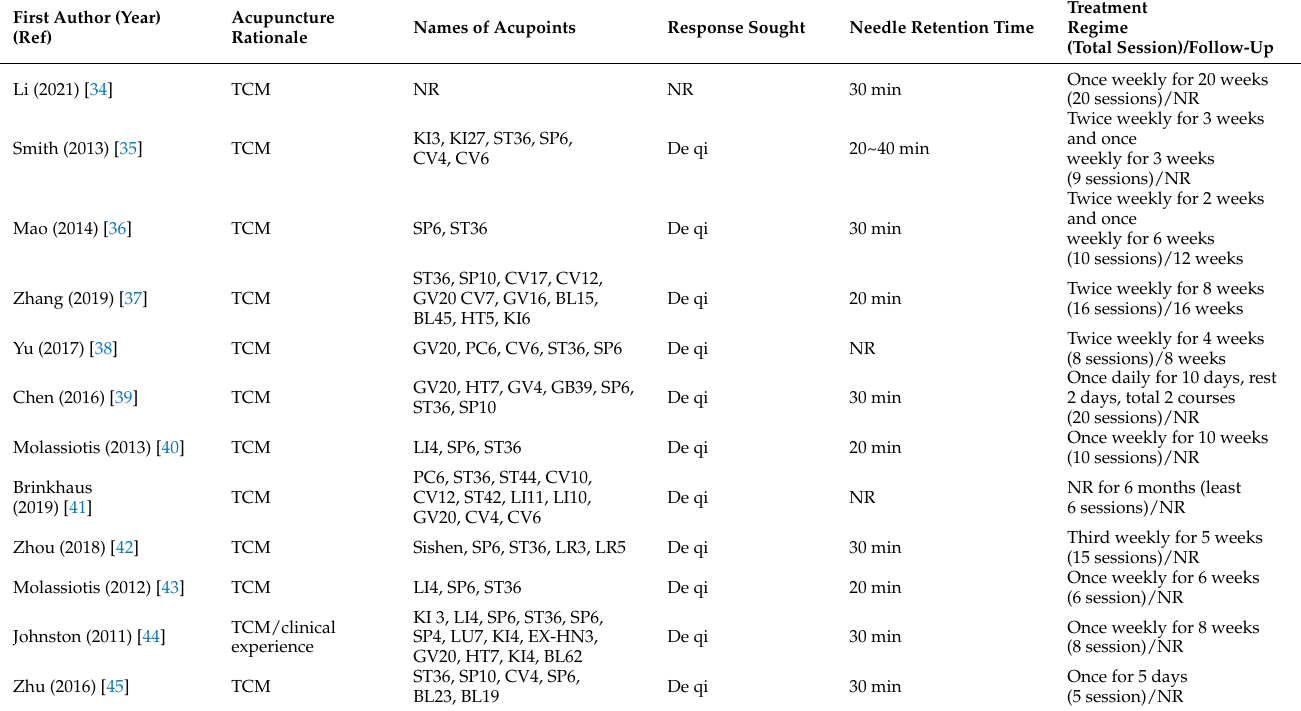
Table 2. Descriptions of the acupuncture